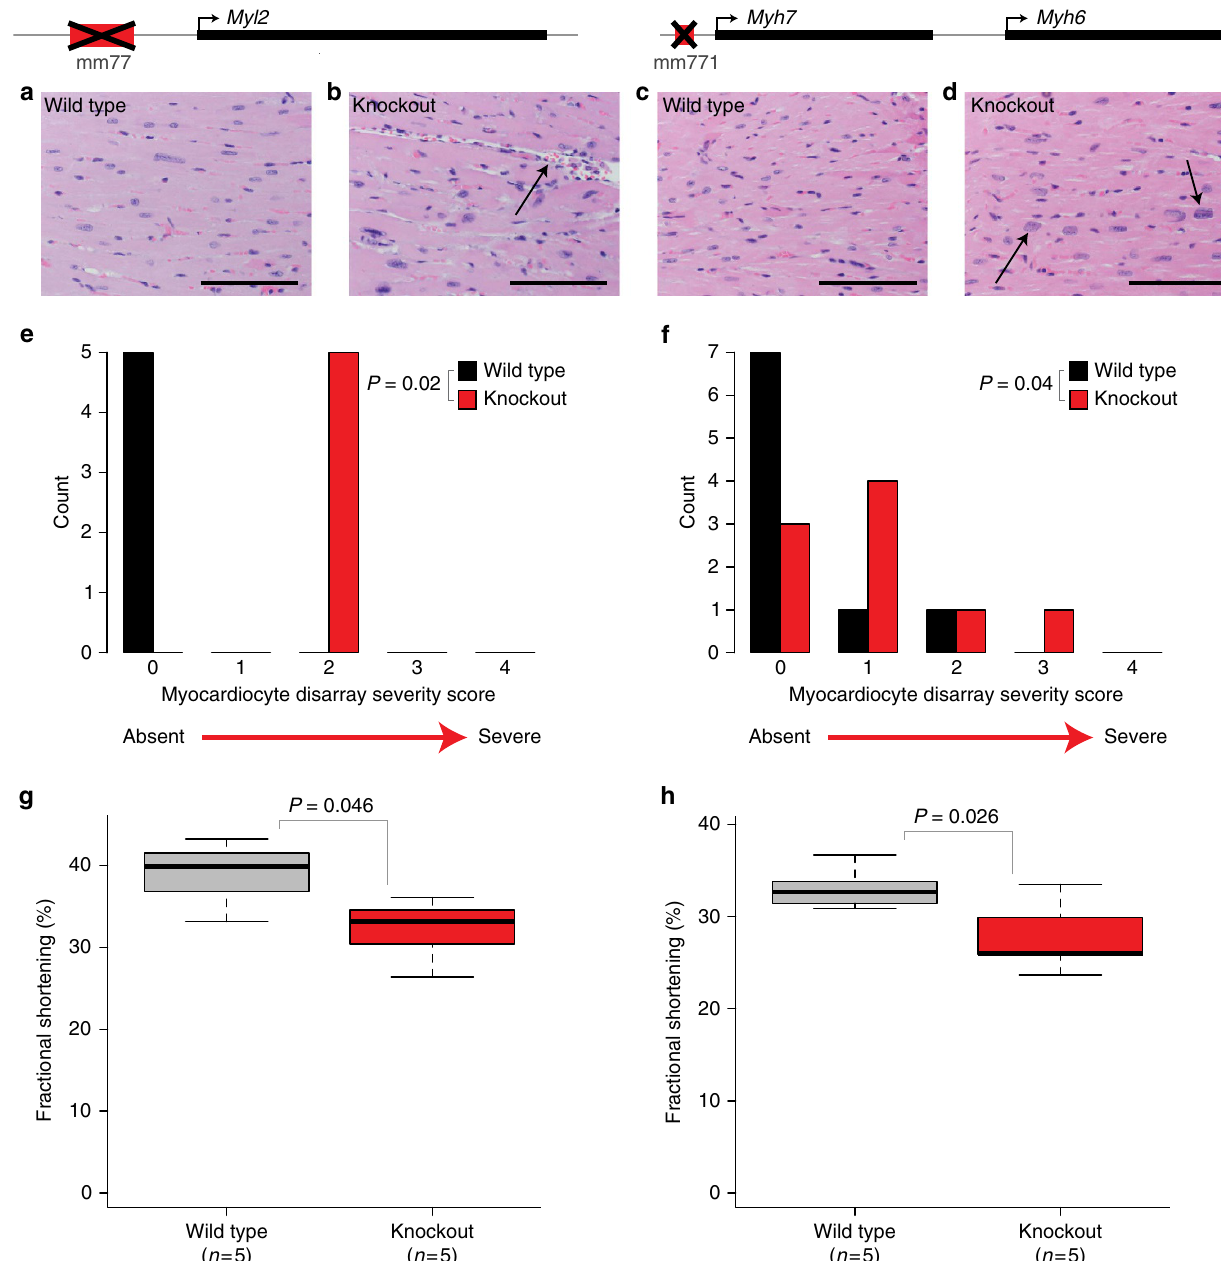
Figure 5 | Loss of heart enhancers results in cardiac abnormalities. ( a – d ) Representative images of haematoxylin and eosin stained heart tissue from mice wild-type ( a , c ) or homozygous null ( b , d ) for the mm77 ( a , b ) or mm771 ( c , d ) enhancers. ( b ) Characteristic myocardiocyte disarray (arrow) observed in a homozygous D mm77 mouse. ( d ) Myocardiocyte karyomegaly (arrows) observed in a homozygous D mm771 mouse. Scale bars, 100 m m. ( e , f ) Severity of myocardiocyte disarray observed in the hearts of mice wild-type or homozygous null for the mm77 ( e ) or mm771 ( f ) enhancer. Cardiac tissue was scored by a genotype-blind pathologist from 0 (absent) to 4 (severe), and P values calculated by one-tailed paired Wilcoxon rank-sum test. ( g , h ) Cardiac fractional shortening for mice wild-type and homozygous null (knockout) for the mm77 ( g ) or mm771 ( h ) enhancer. For ( g , h ) Boxplots indicate median, range and quartile values for each data set, and P values were calculated by one-tailed paired t homozygous null for mm771 have 5–10% lower body weight than wild-type females ( P o 0.05, one-tailed t -test), but no growth phenotypes were observed for mm771 males or for mm77-null mice of either gender (Supplementary Fig. 8). To assess gene expression changes resulting from the loss of either enhancer, we performed RNA sequencing on heart tissue from E11.5 and adult mice from each enhancer deletion line. In mice homozygous null for mm77, Myl2 RNA expression is reduced by 75–80% compared with wild-type levels at both E11.5